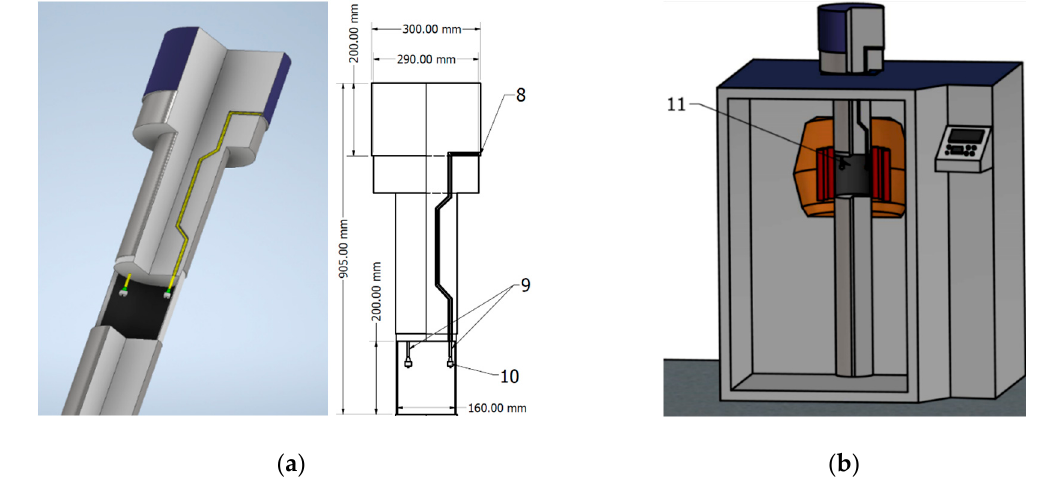
Figure 4. Schematic details of the irradiator tube: ( a ) Section views, 8. Cable Channel, 9. Connection fibers, 10. Fiber connectors; ( b ) Exposure zone of gamma chamber, 11. Area surrounded by Co-60 bars.